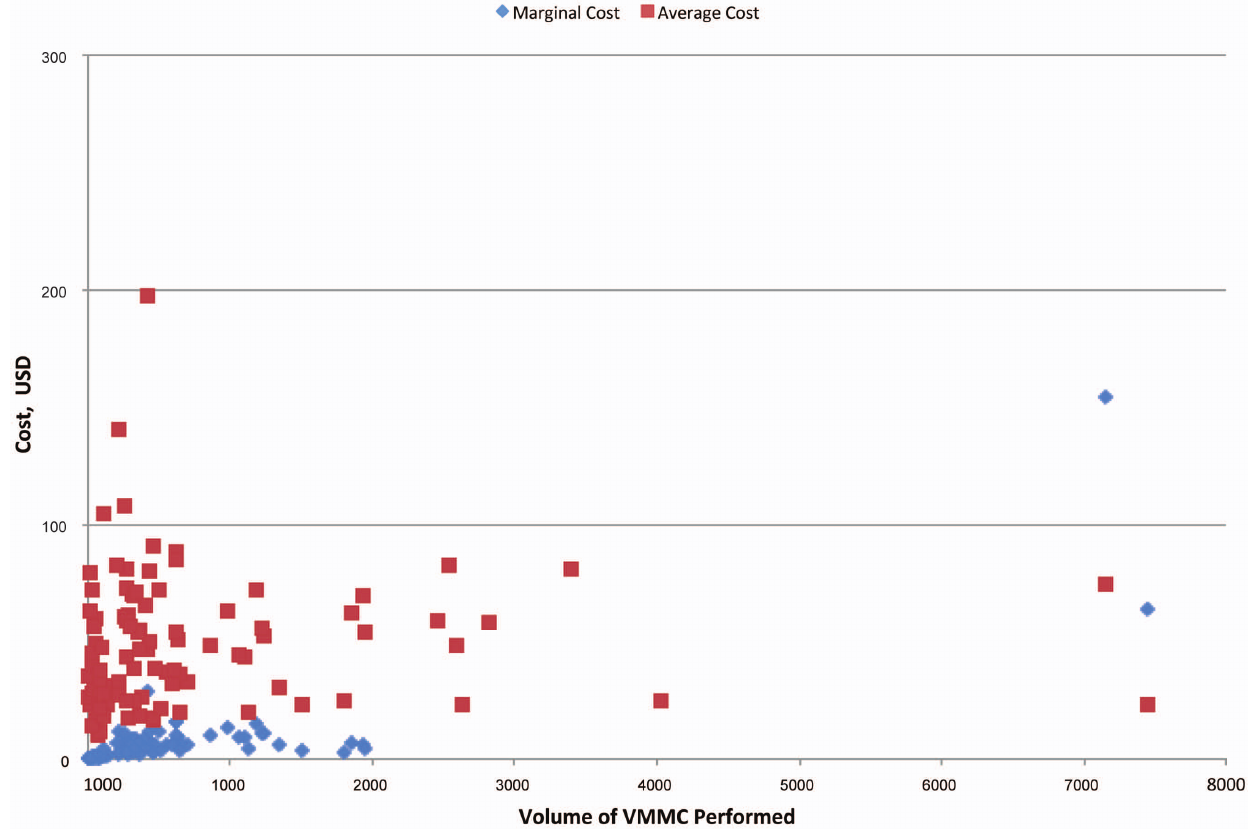
Figure 1. Predicted average and marginal cost of VMMC programs. Red square: Average cost. Blue diamond: Marginal cost.